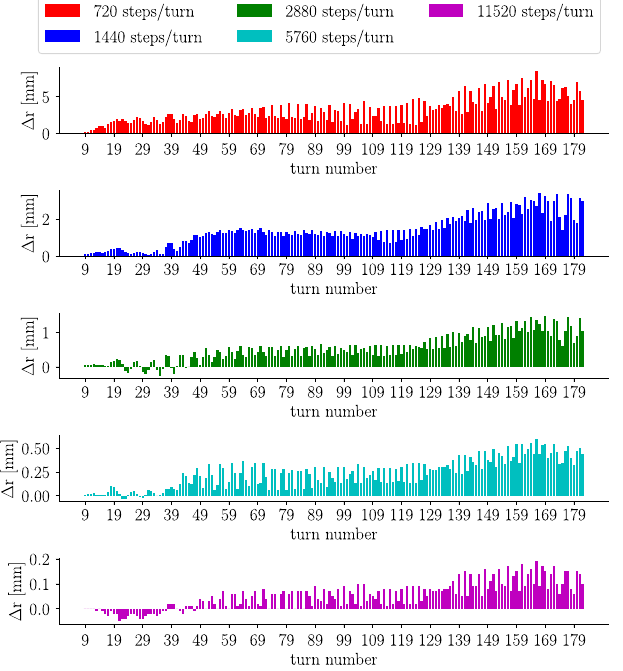
FIG. 16. Difference of the turn radius Δ r at probe RRL between simulations due to the number of integration steps per turn. The reference simulation uses 23 040 steps per turn. The input param- eters of the simulation are optimized for 2880 steps per